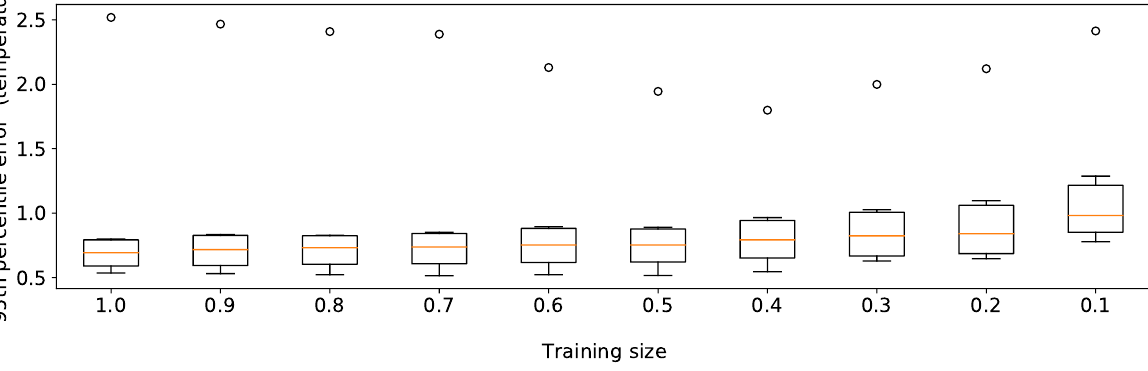
Figure 19. XGBoost results obtained by varying the training set